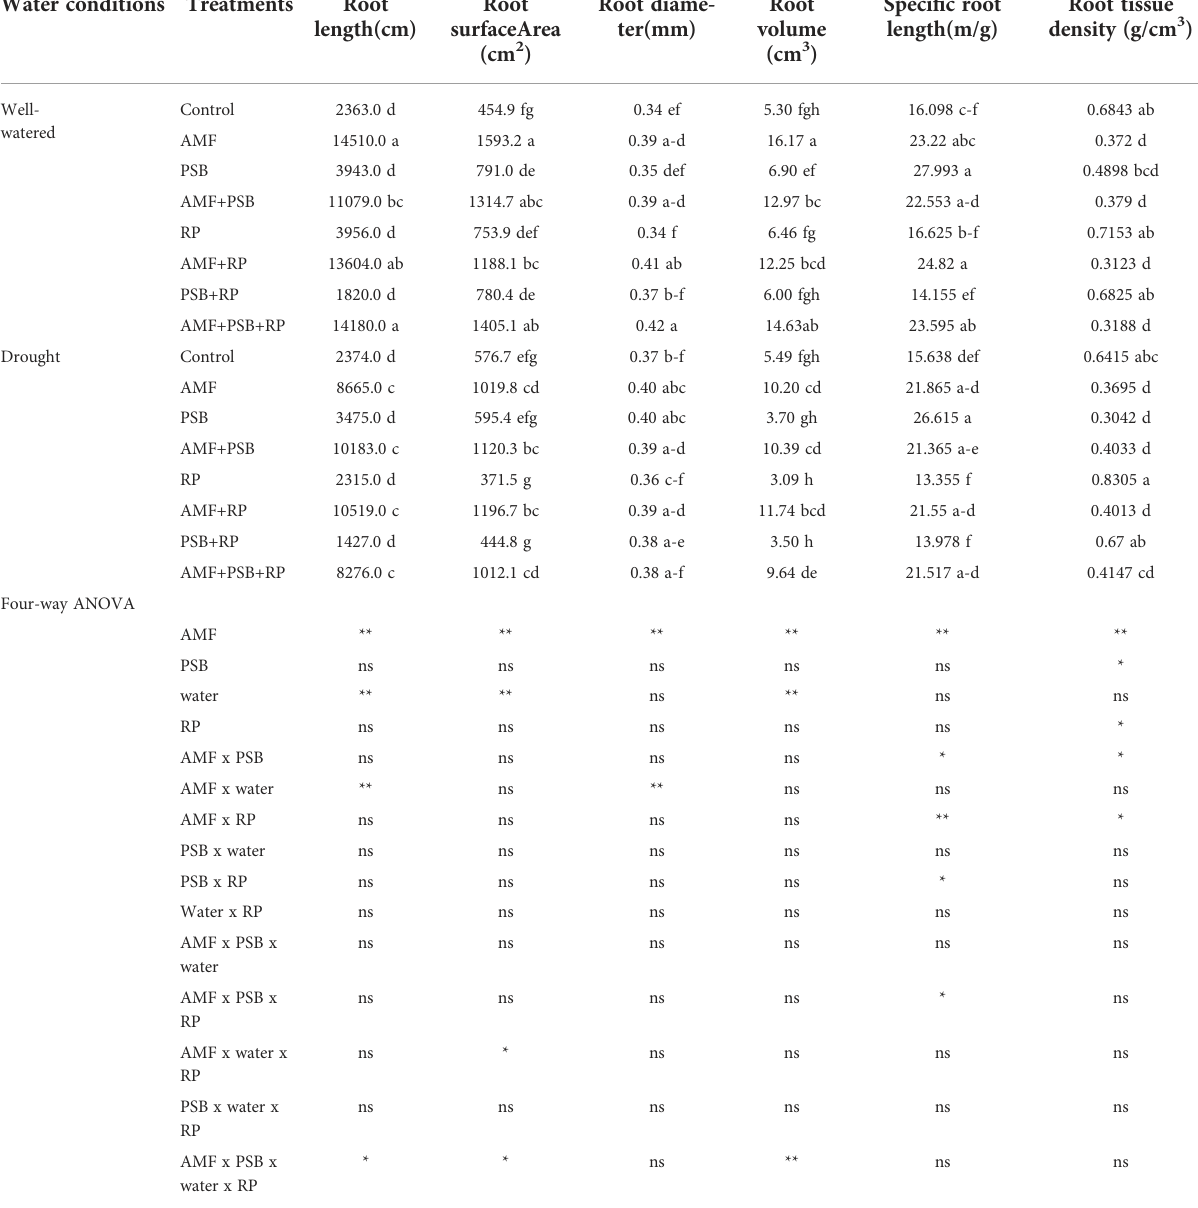
TABLE 3 Root growth performance of sunchoke treated with AMF and PSB under well-watered (WW) and drought (DS) conditions, in the presence and absence or RP, evaluated at 60 DAT. Water conditions